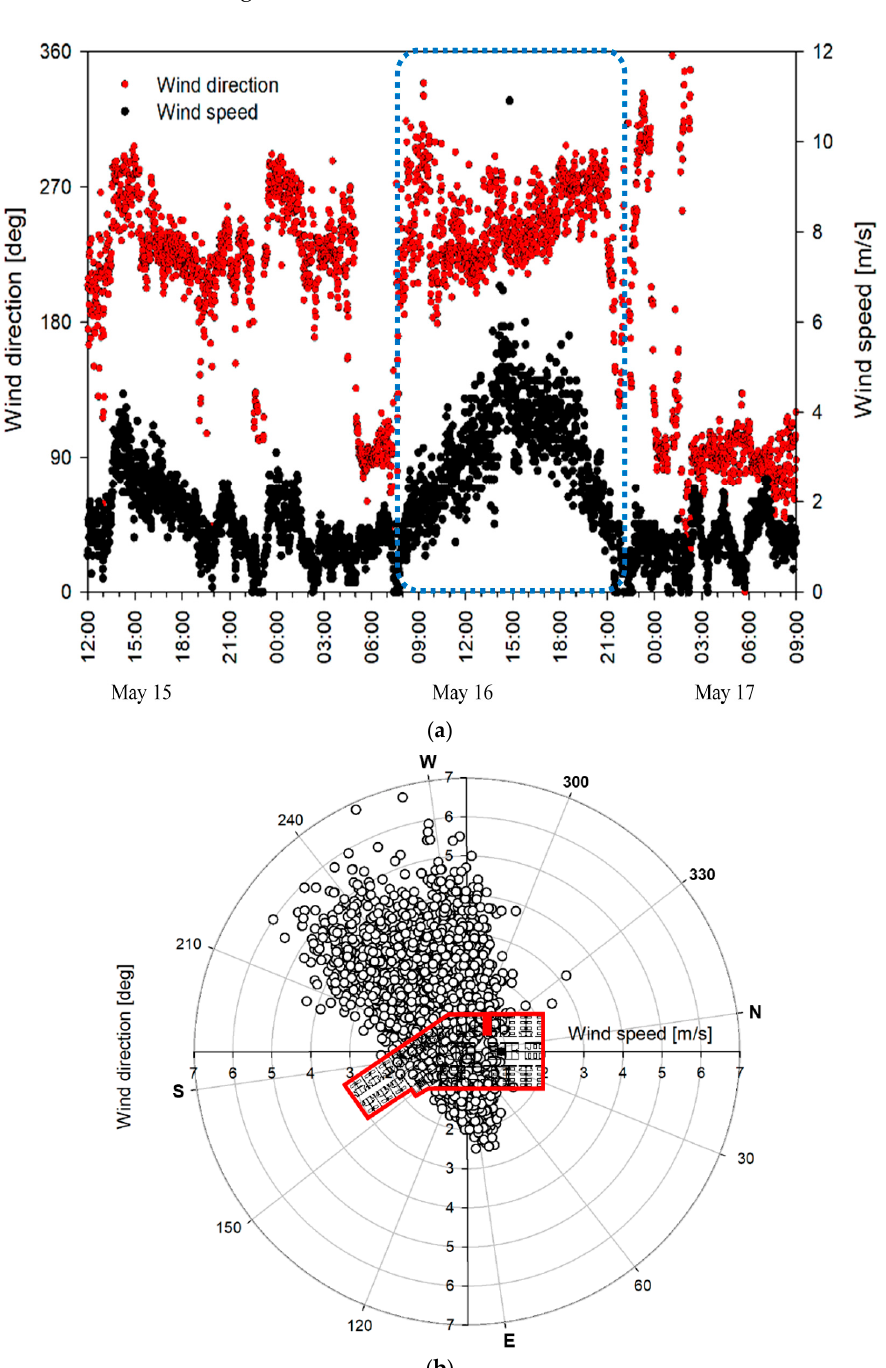
Figure 5. Outdoor airflow during the stay of the initial patient: ( a ) wind profile; ( b ) wind rose graph.